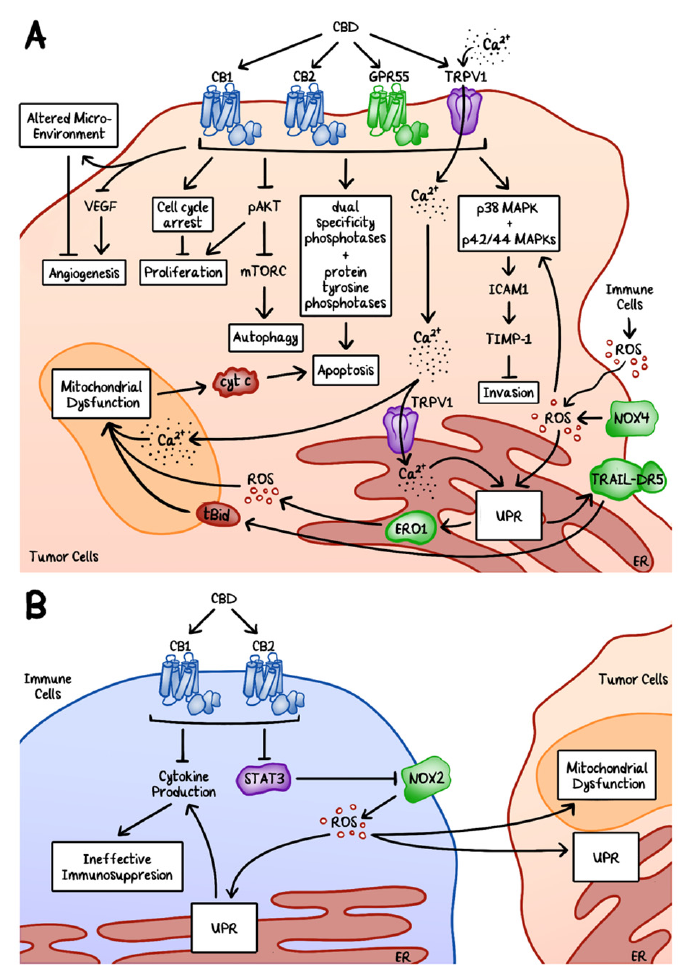
Figure 5. CBD’s e ff ects on cancer cells and infiltrating immune cells. ( A ) Through its interactions with the CB 1 , CB 2 , and TRPV1 receptors, CBD induces cell cycle arrest and apoptosis in cancer cells. ( B ) CBD also binds the CB 1 and CB 2 receptors on the infiltrating inflammatory cells and disrupts the pro-tumorigenic cytokine production, thus leading to ine ff ective immunosuppression and promoting tumor cell death. ROS production by phagocytic cells disrupts the ER and mitochondrial homeostasis in tumor cells leading to apoptosis. UPR: unfolded protein